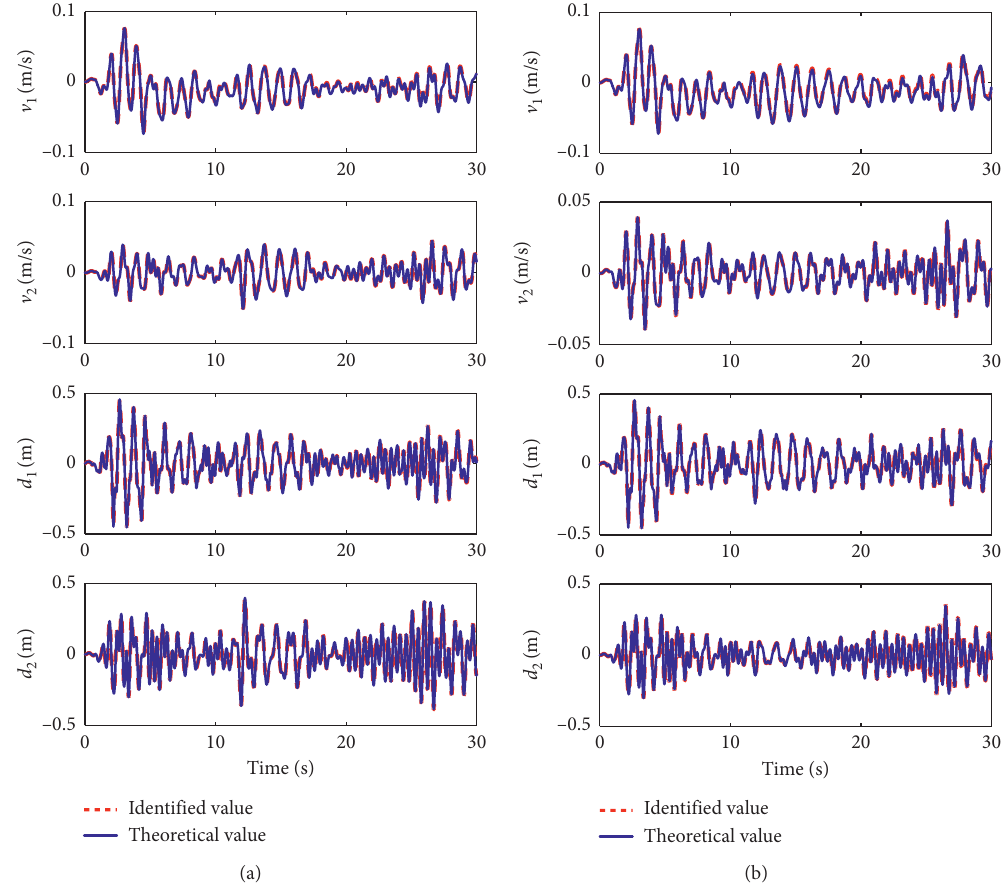
Figure 21: Comparison of velocities and displacements under El-Centro earthquake wave. (a) Case 1. (b) Case